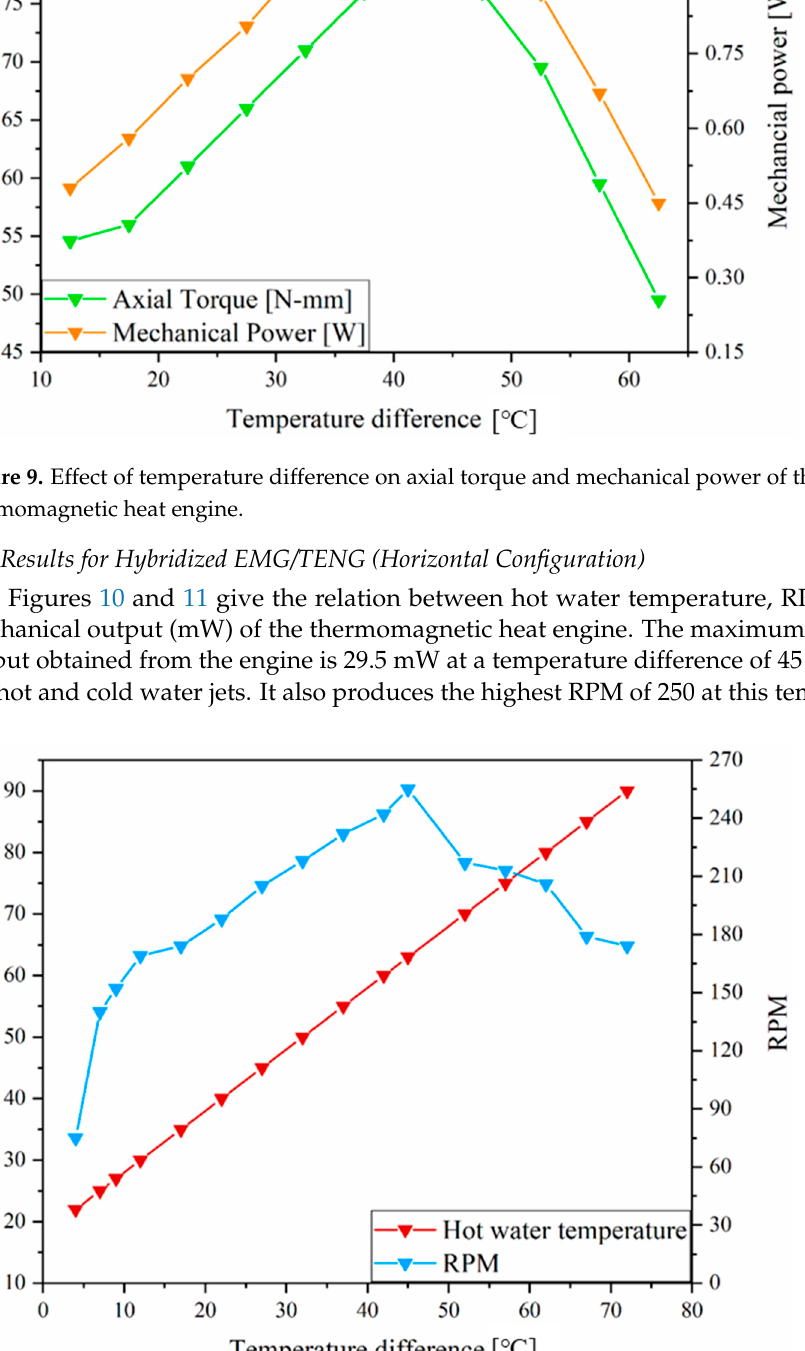
Figure 8. The effect of temperature difference on RPM of the cylindrical thermomagnetic heat en- gine.